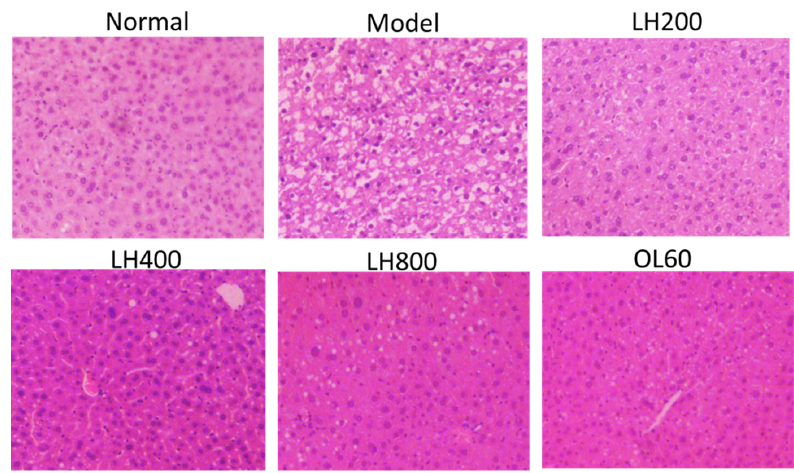
Figure 5. Effects of LH on the liver pathology of mice. H&E staining (100× magnification). Normal, normal group; model, high-fat control group. LH200, LH400, and LH800: groups orally treated with LH at dosages of 200, 400, and 800 mg/kg/day, respectively; OL60: group orally treated with OL at 60 mg/kg/day (n = 10).